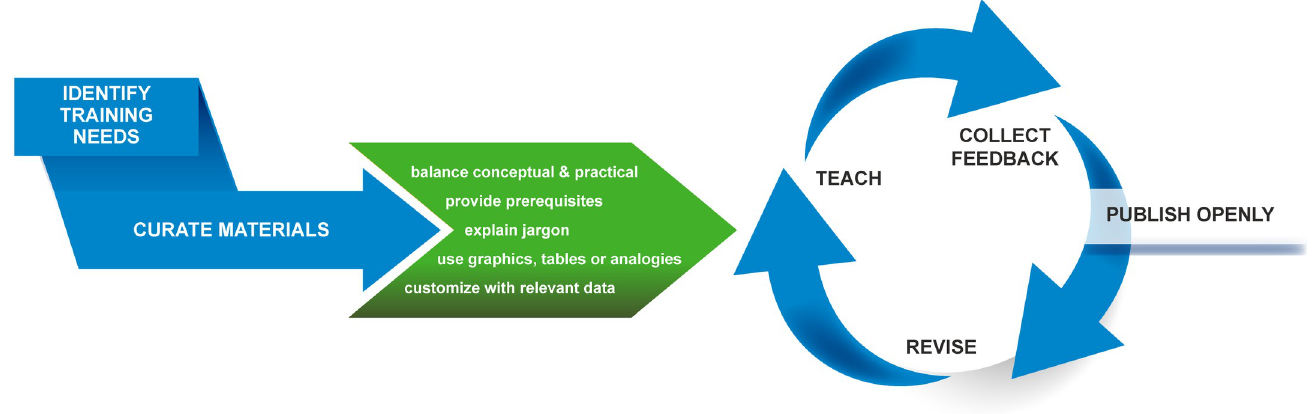
Fig 1. A process for efficient bioinformatics curriculum development and training. Effective training starts with identification of training needs. Existing materials that meet these training needs are curated and adapted to suit the audience. Adapted materials are tested and refined through teaching, feedback, and revision. The refined curricula are published openly for broad dissemination and